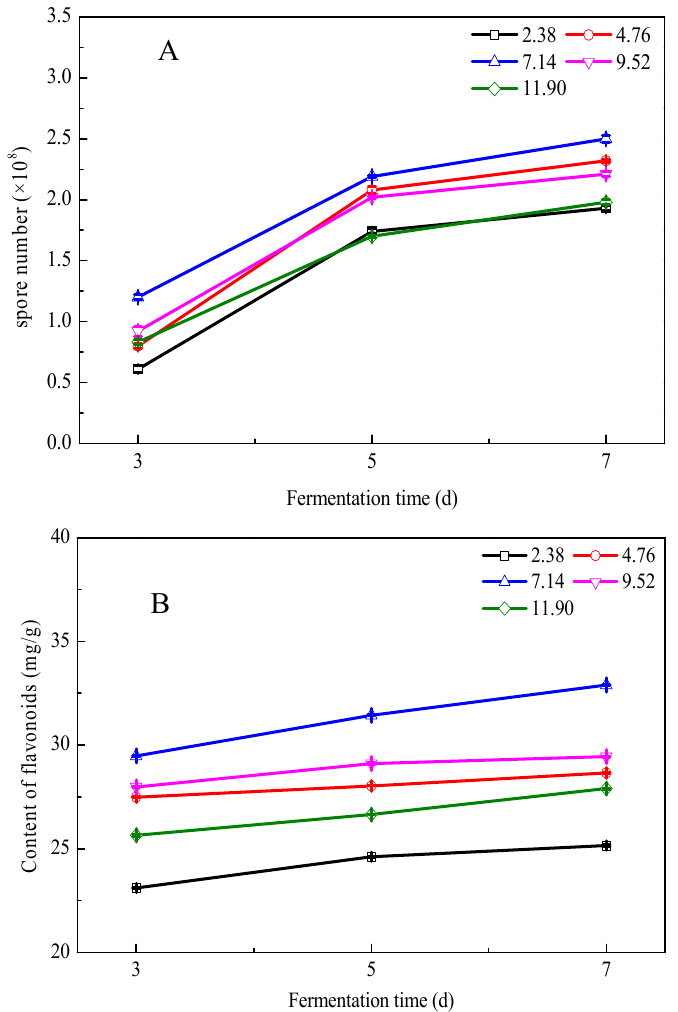
Figure 4. E ff ects of inoculum size ( × 10 6 CFU) on di ff erent indexes: ( A ) spore number, and ( B ) Figure 4. Effects of inoculum size (×10 6 CFU) on different indexes: ( A ) spore number, and (B) flavonoid flavonoid content.